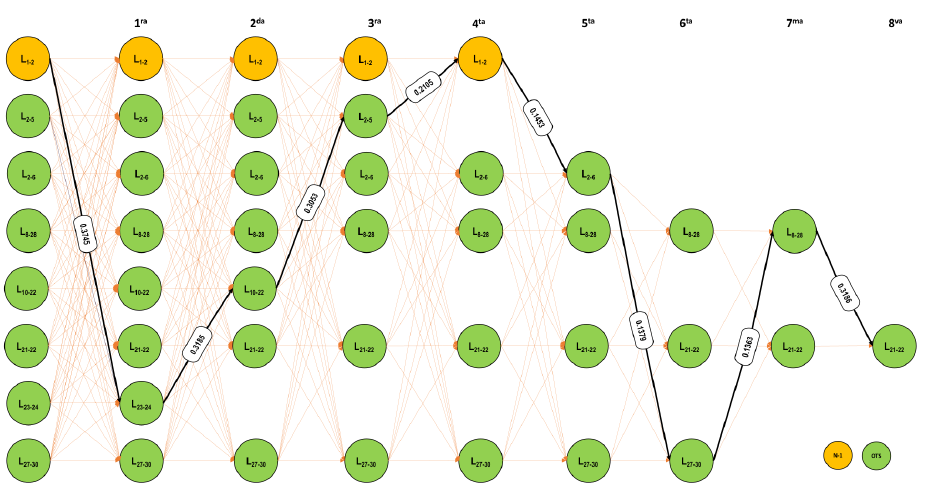
Figure 3. Re-connection lines for the 30 bus bar system. The variation in the angle of voltage δ in bus bars is presented in Figure 4 for the 30-bus system in a normal state. Additionally, a new contingency state N − 1, the change of state with the result of the OTS, and finally the connection options of the disconnected lines SW for system restoration are shown as well.